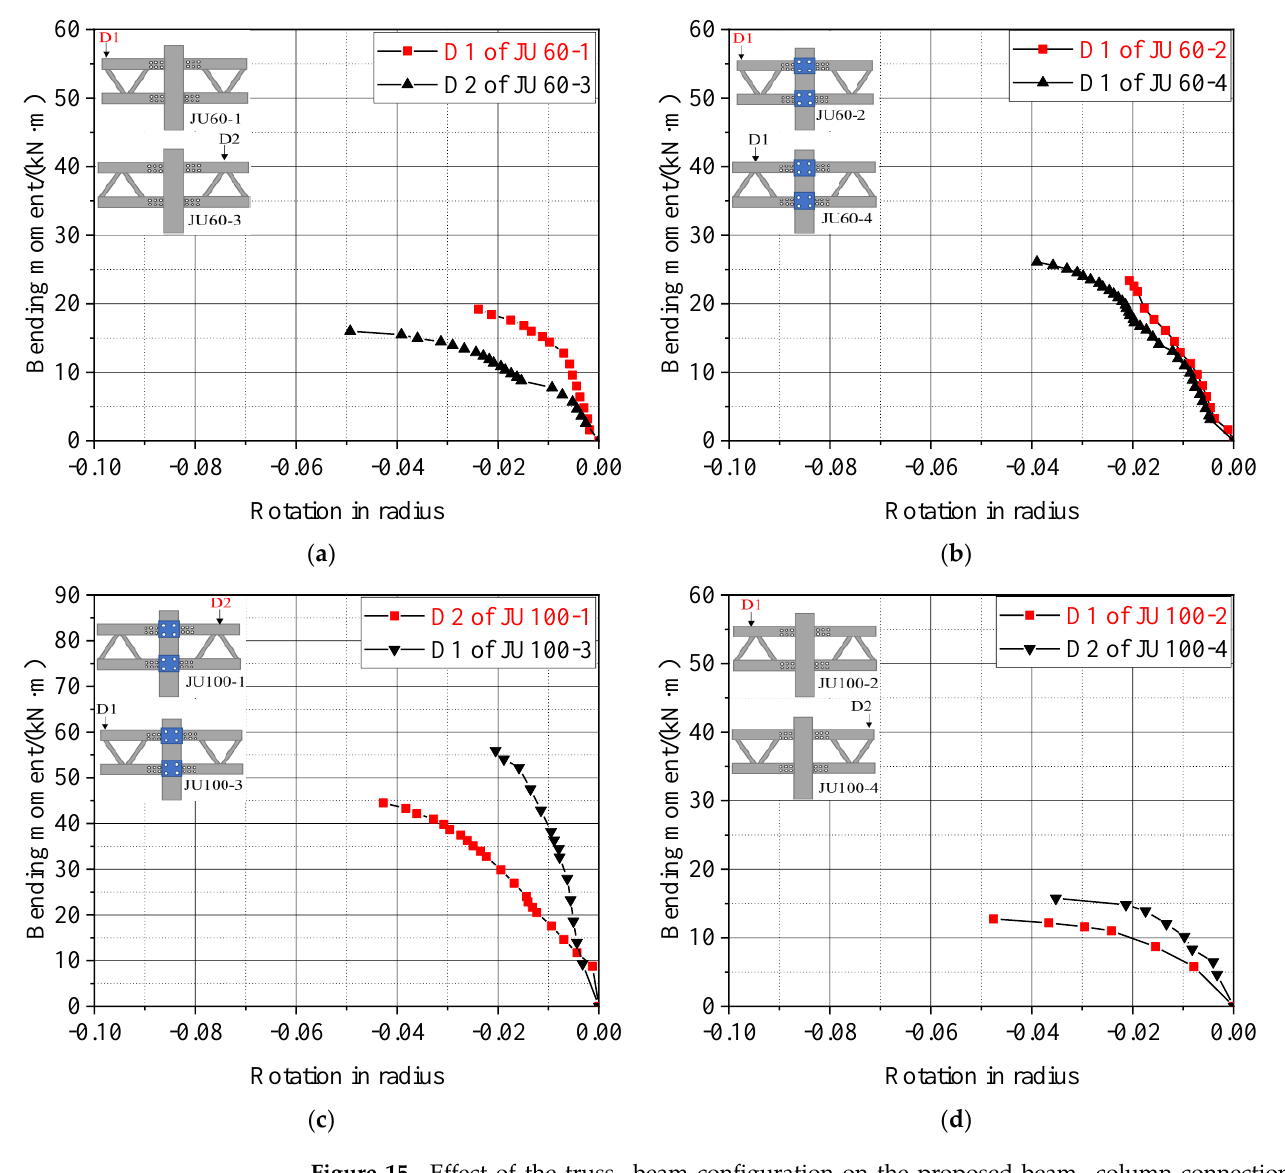
Figure 15. Effect of the truss − beam configuration on the proposed beam − column connection. ( a ) JU60 − 1 and JU60 − 3, ( b ) JU60 − 2 and JU60 − 4, ( c ) JU100 − 1 and JU100 − 3, ( d ) JU100 − 2 and JU100 − 4.